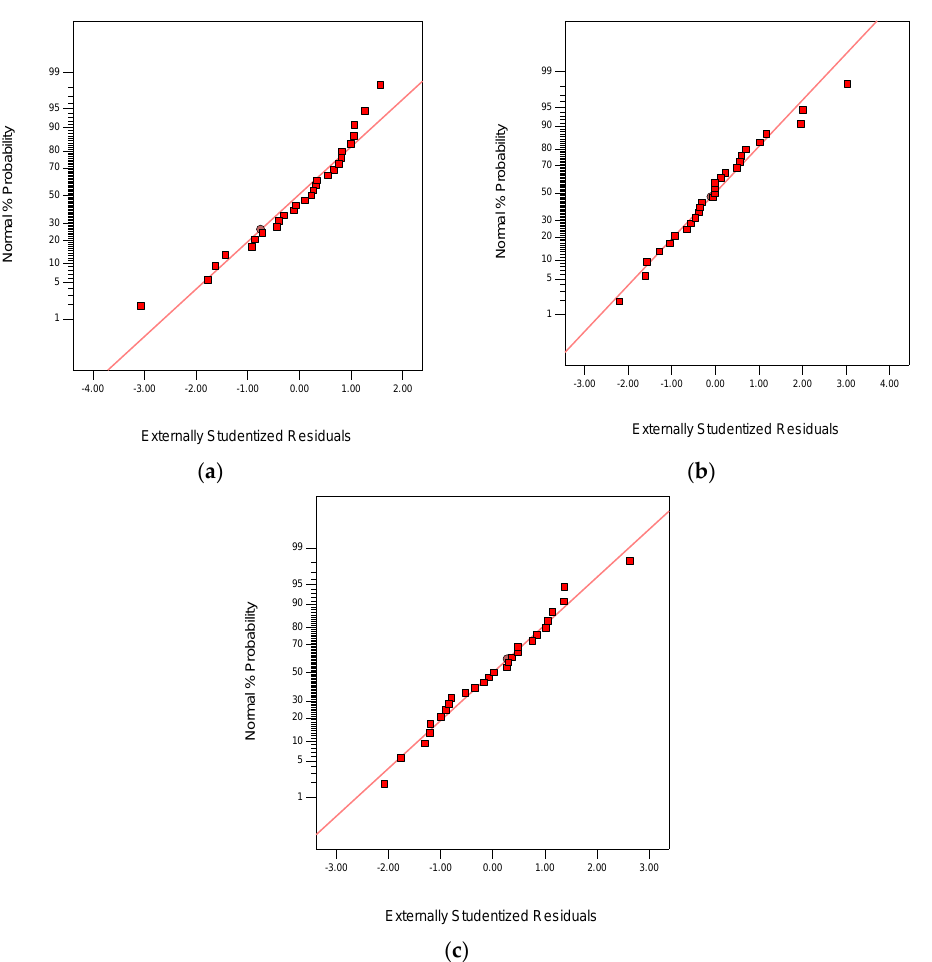
Figure 3. Normal probability plot residuals for the responses: ( a ) flexural strength; ( b ) impact strength; ( c ) ILSS.